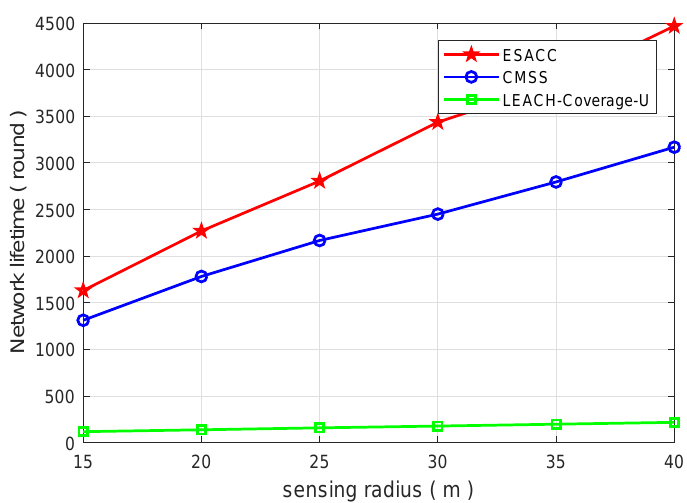
Figure 9. Relationship between network lifetime and sensing radius r s .